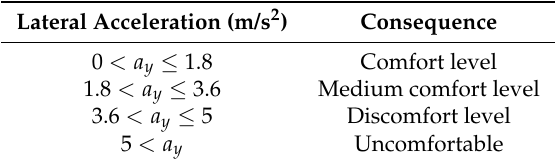
Table A1. Lateral acceleration thresholds of comfort.